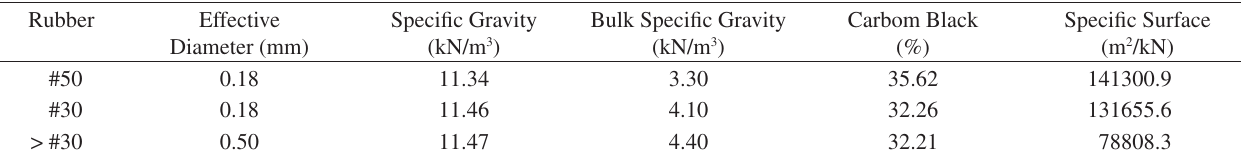
Table 3. Properties of rubber.